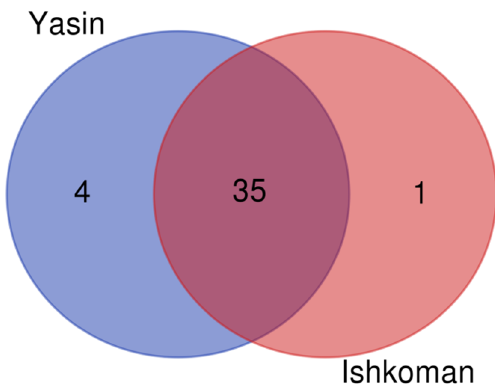
Figure 8. Venn diagram showing the overlap among the studied groups in both valleys for the recorded wild food